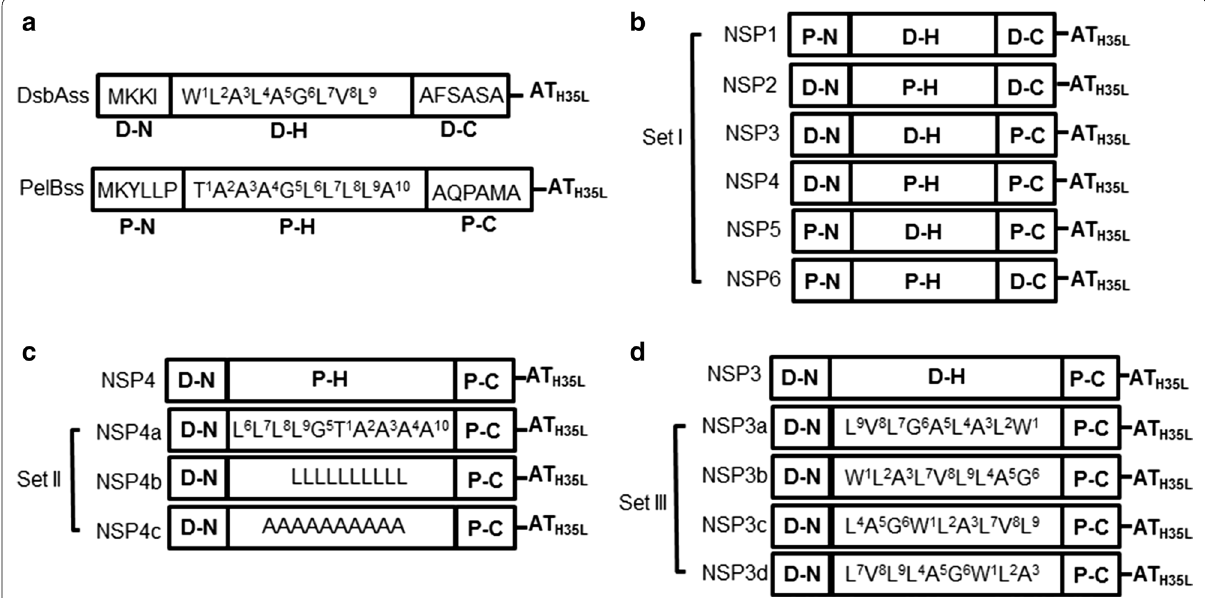
Fig. 2 Schematic representation of the novel signal peptide constructions used to express secreted AT H35L . a DsbAss and pelBss used as paren- tal signal peptides. D–N, D–H and D–C represent the n-, h- and c-regions of dsbAss, respectively and P–N, P–H and P–C represent the n-, h- and c-regions of pelBss, respectively. b Set I novel signal peptides, NSP1–NSP6, were created by shuffling the n-, h- and c-regions from dsbAss and pelBss. c Set II novel signal peptides. NSP4a–NSP4c were created by modifying the h-region of NSP4 by changing the position of amino acid resi- dues or substituting residues with polyleucine or polyalanine. d Set III novel signal peptides. NSP3a–NSP3d were created by modifying the position of amino acid residues in the h-region of NSP3. In c , d Numbers next to individual amino acids in the h-region indicate the original position in the h-region in ( a